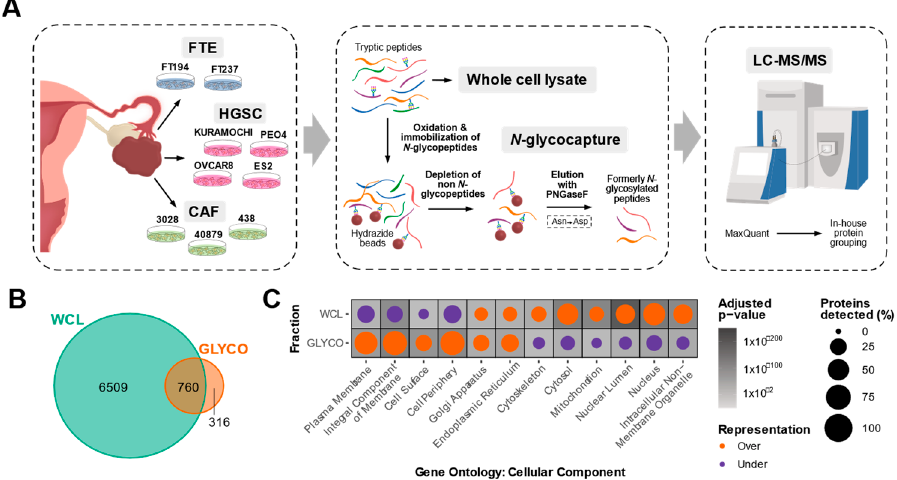
Figure 1. Overview of in vitro HGSC proteomic characterization . ( A ) Schematic of in vitro proteomic workflow. Whole cell lysate (WCL) and N -glycopeptide (GLYCO) enriched fractions of three high-grade serous ovarian cancer (HGSC) patient-derived cancer-associated fibroblast (CAF) cultures, four immortalized HGSC epithelial lines and two immortalized normal fallopian tube epithelial (FTE) lines were analyzed by liquid chromatography-tandem mass spectrometry (LC-MS/MS). Each cell line was processed in four replicates. ( B ) Venn diagram of proteins detected in each fraction. ( C ) Dot plot depicting statistically significant over- (orange) and under-represented (purple) Gene Ontology: Cellular Component terms in each fraction. Size of the circles correspond to the percentage of proteins detected in each fraction annotated with the respective term and the background shading indicates the adjusted p-value.